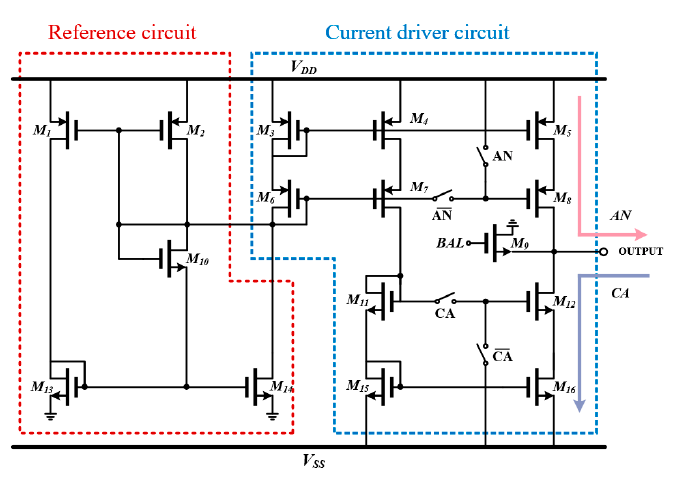
Figure 7. Push–pull structure-based biphasic current driver circuit wherein the reference current is supplied from a beta-multiplier reference circuit.